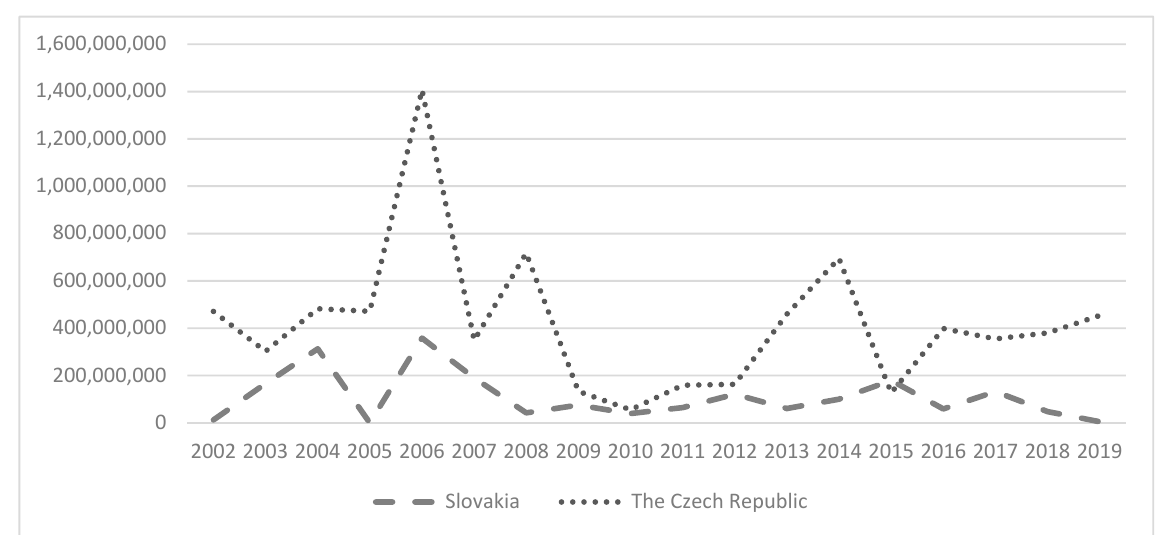
Figure 1. Development of the total volume of provided investment incentives in Slovakia and the Czech Republic. Source: Own processing based on data from Ministry of Economy of the Slovak Republic and www.czechinvest.org.